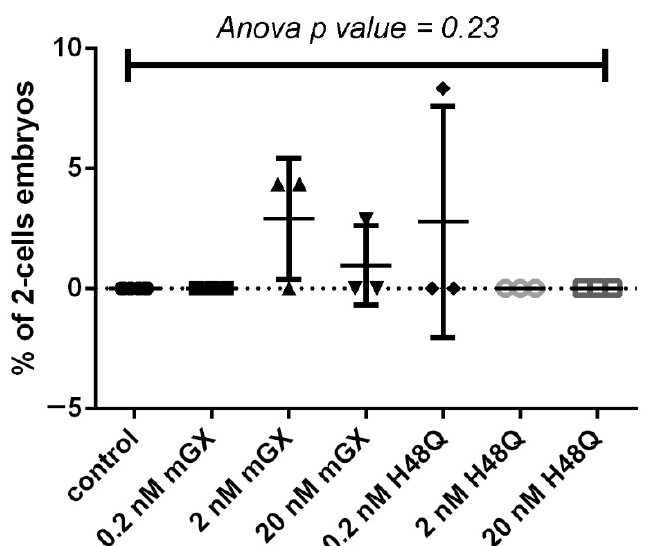
Figure 2. H48Q-PLA2G10 and WT-PLA2G10 do not activate parthenogenesis of MII oocytes from C57BL/6 mice. Batches of MII oocytes (22–36 oocytes per batch) were incubated in M16 medium in an incubator at 37 °C and at 5% CO 2 24 h in control medium (black circles) or with different concen- trations of WT-PLA2G10 (black squares, up and down triangles) and H48Q-PLA2G10 (noted H48Q) (black diamonds, Grey circles, grey open squares), as indicated. The percentage of pathenogenotes at 2-cell stages was counted after 24 h for each condition. n = 3–5, depending on condition. Statistical difference was challenged with a one-way ANOVA test. p -value as indicated.